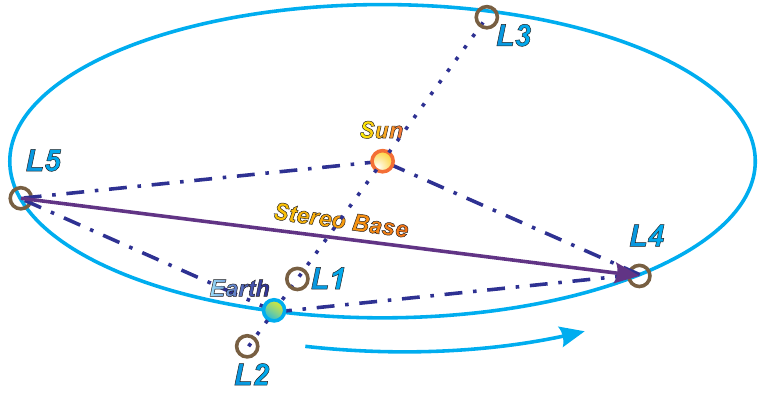
Fig. 1. Western ( L 4) and Eastern ( L 5) points that follow Earth in its orbit. They are centers of libration orbits of a third body in the circular restricted three-body problem. The full system of libration centers – solutions to this problem – includes five points, three of which ( L 1, L 2, and L 3) were discovered by Euler (1767), while the remaining two by Lagrange (1772) five years